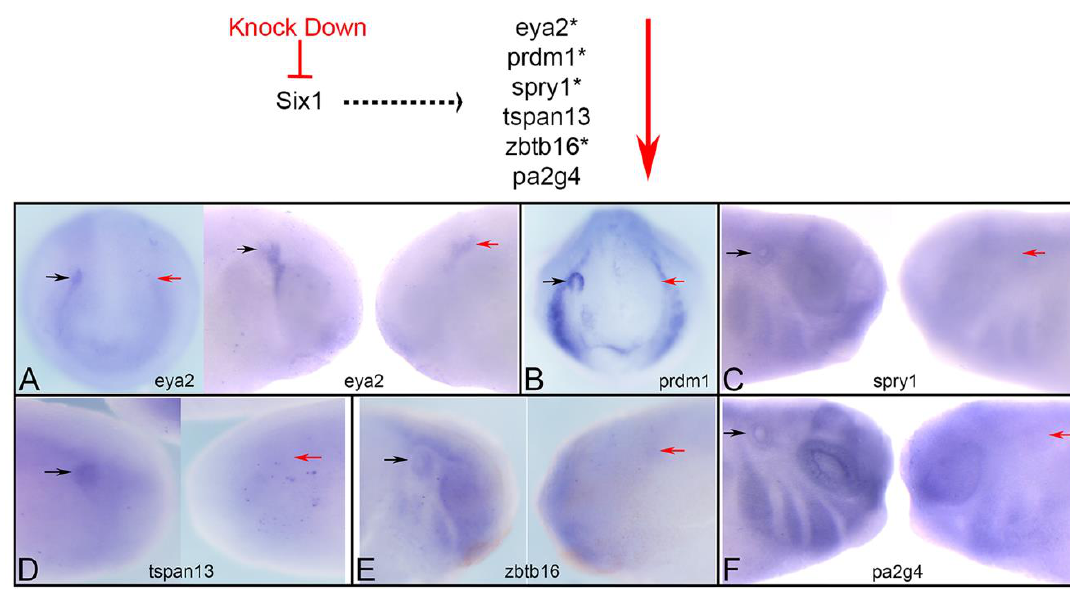
Figure 1. Six1 is required for otic gene expression. Top: Six1 is predicted to act upstream of the investigated genes. If correct, then the expression domain and/or intensity should be reduced (red arrow) when Six1 is knocked down. Those genes with an asterisk were shown to have Six1 bound to an enhancer in mouse E10.5 otic vesicles [42]. We found that the otic placode (( A ), left image) or otic vesicle (( A ), right image, ( B – F )) expression of eya2 ( A ), prdm1 ( B ), spry1 ( C ), tspan13 ( D ), zbtb16 ( E ) and pa2g4 ( F ) was reduced on the MO-mediated knock-down side of each embryo (red arrow) compared to the control side (black arrow) of the same embryo. A, left image and B are frontal views; A, right image and C-F are side views. Dorsal is to the